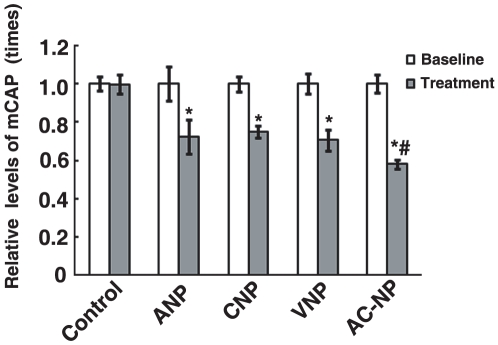
Effect of AC-NP on mean carotid arterial pressure (mCAP) in rats.The mCAP values were normalized against the corresponding values of baseline, which were arbitrarily set as 1. Data are expressed as means ± SEM, n = 6. *P<0.05 versus baseline. # P<0.05 versus ANP, CNP, or VNP group. Saline was used as control.